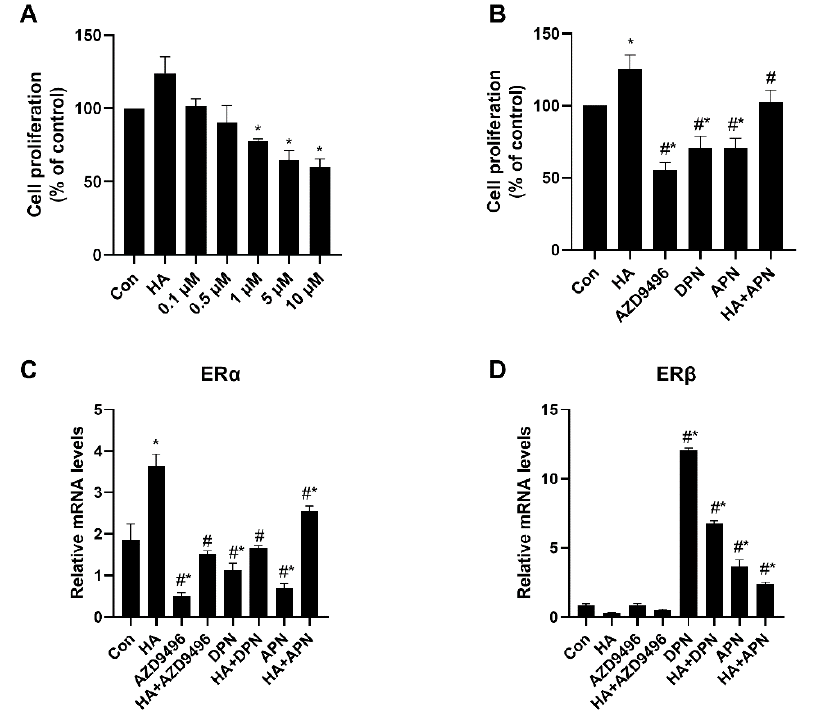
Figure 4. Inhibition e ff ects of apigenin on HeLa cell proliferation. ( A ) HeLa cell proliferation after treated with di ff erent concentration of apigenin (0.1, 0.5, 1, 5, 10 µ M). Cell proliferation was measured after incubation with apigenin for 48 h. ( B ) E ff ects of HA, AZD9496, DPN and apigenin treatment on HeLa cell proliferation. The concentration of AZD9496 and DPN was 1 µ M. ( C ) The mRNA expression levels of ER α . ( D ) The mRNA expression levels of ER β . The results are expressed as a percentage of control, which is set at 100%. The concentration of apigenin used in ( B – D ) was 5 µ M. The detailed primer sequence used in this part is shown in the materials and methods section. Data are presented as the mean ± SEM of at least three independent experiments. * p < 0.05 versus the control group, # p < 0.05 versus the HA group.